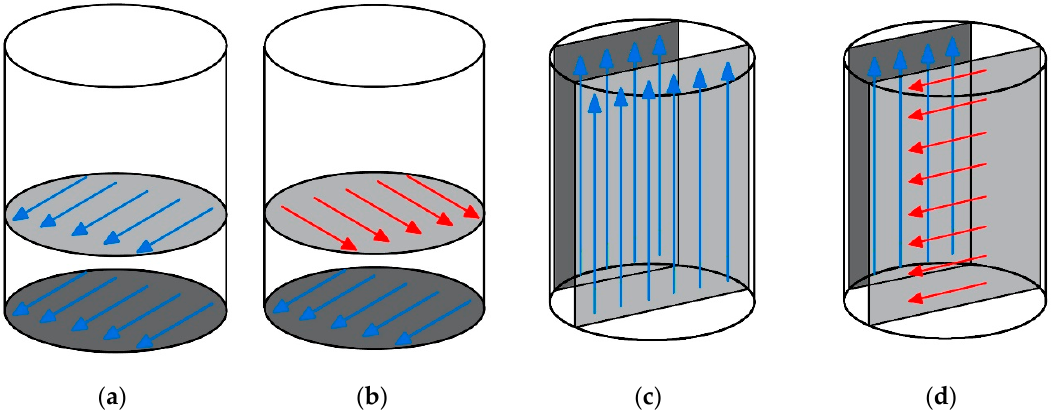
Figure 6. Layout of the tracks in samples for compression tests: ( a ) “Parallel”; ( b ) “perpendicular”; ( c ) “vertical”; ( d ) “mixed”.